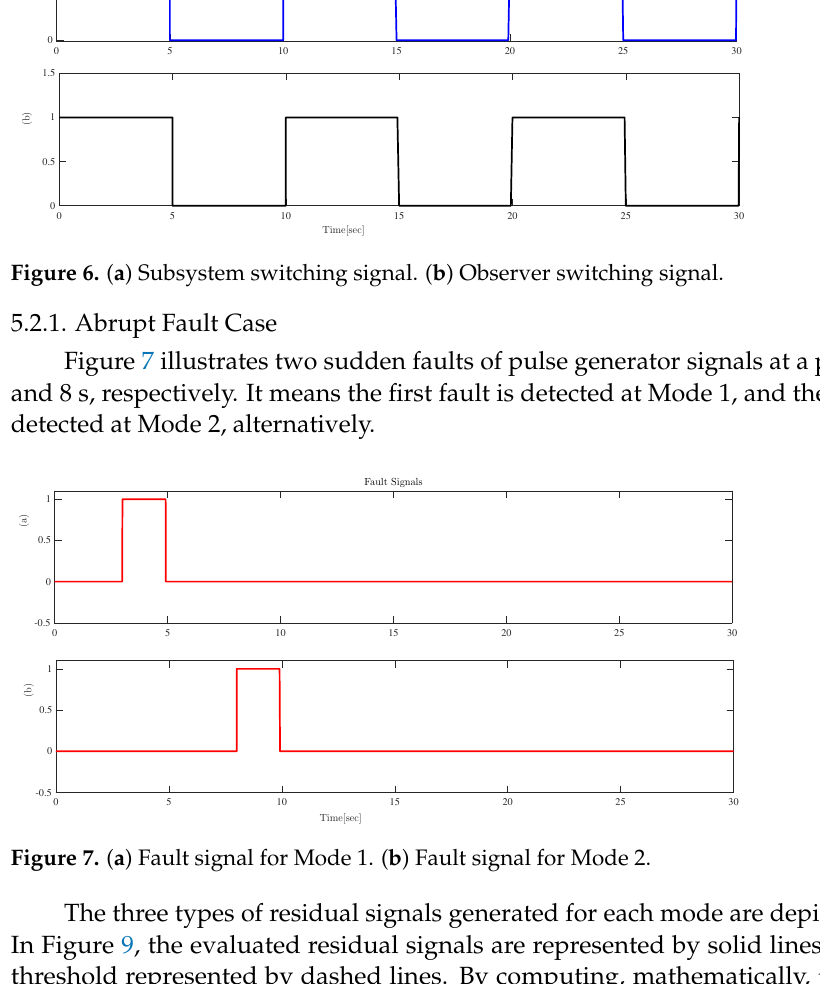
Figure 7. ( a ) Fault signal for Mode 1. ( b ) Fault signal for Mode 2. The three types of residual signals generated for each mode are depicted in Figure 8. In Figure 9, the evaluated residual signals are represented by solid lines, with adaptive threshold represented by dashed lines. By computing, mathematically, the threshold is set by using (20), where the constant threshold for both the modes is calculated offline as = 0.1451 and j = 0.2365. Thus, the adaptive threshold for Mode 1 is calculated at j thd thd 2 1 τ = 3.7862 as J th 1 = 0.8456, and J th 2 = 0.6462 at τ = 8.563 for Mode 2. A fault is detected when the residual evaluated is greater than its threshold, such as r 1 = 0.8458 > 0.8456 and r 2 = 0.6465 > 0.6462, where r 1 and r 2 are residuals evaluated for both the modes.